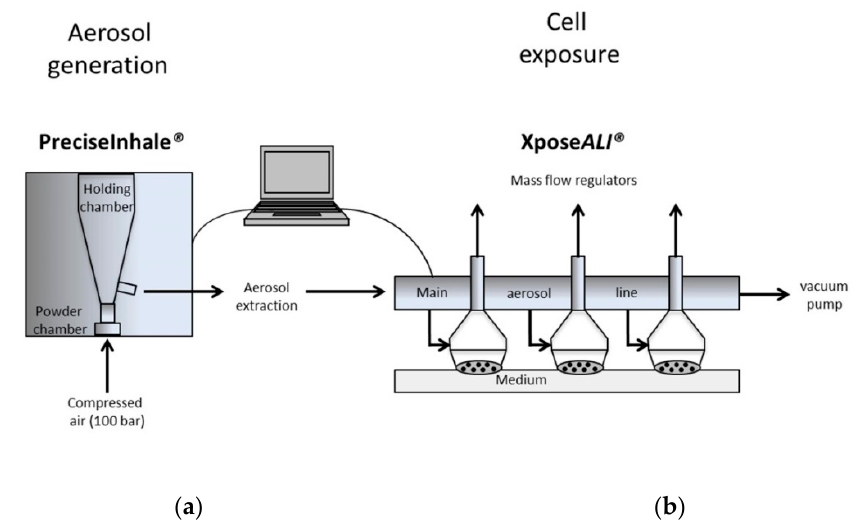
Figure 1. Exposure of cells to an aerosol of cerium dioxide nanoparticles (CeO 2 NPs) generated from dry powders in the PreciseInhale system ( a ) in combination with the Xpose ALI cell exposure unit ( b ). A small amount of powder (typically 2 mg) is loaded into the powder chamber. An aerosol is generated using rapid decompression of powder agglomerates, and the delivered mass can be estimated by a light dispersion instrument. Deposition on cells (5 mL / min flow rate) is analyzed o ffl ine using inductively coupled plasma mass spectrometry